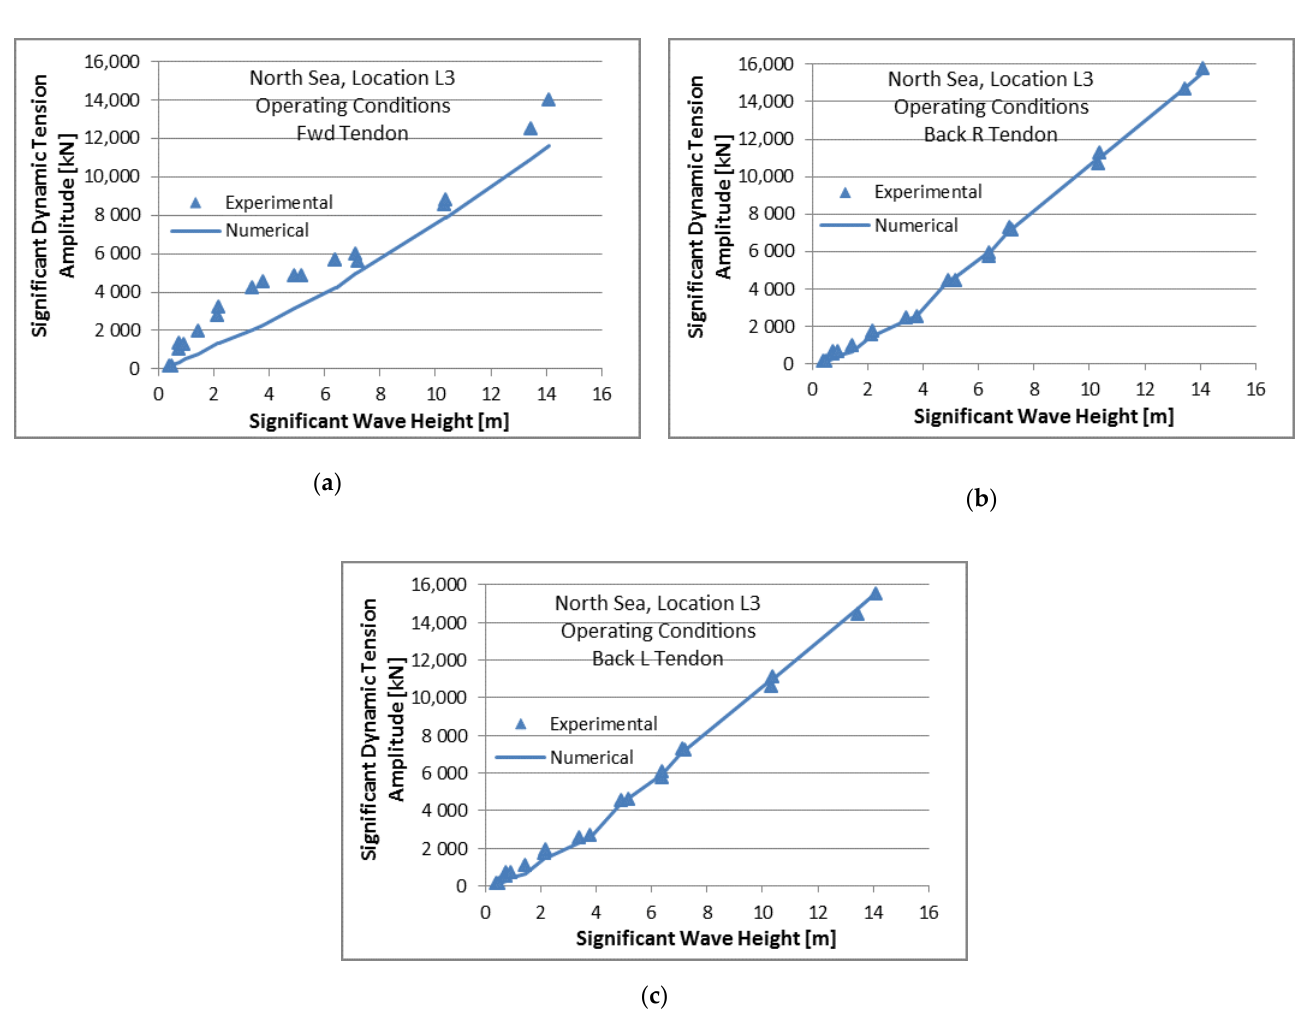
Figure 15. REFOS mooring dynamic tensions comparisons for operating conditions at the North Sea location: ( a ) forward tendon; ( b ) backward left tendon; ( c ) backward right tendon.